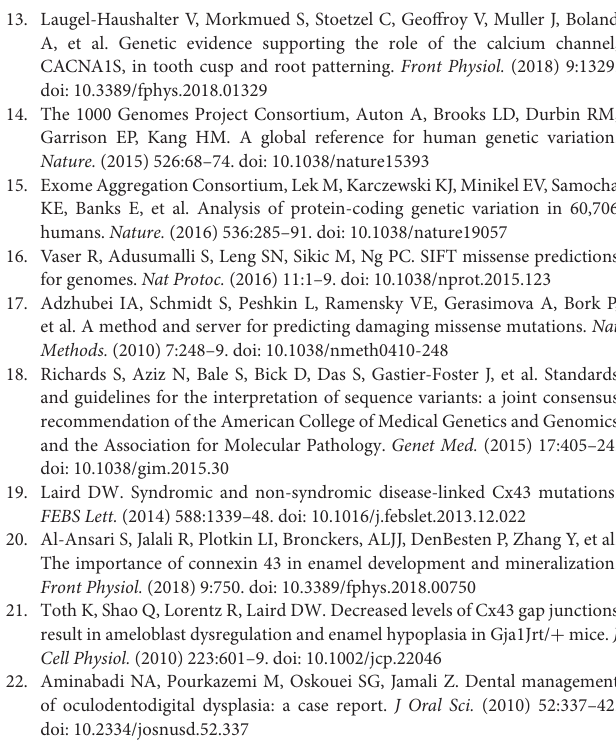
Supplementary Table 1 | Whole-exome sequencing data. https://doi.org/10. 6084/m9.figshare.14387909.v4.